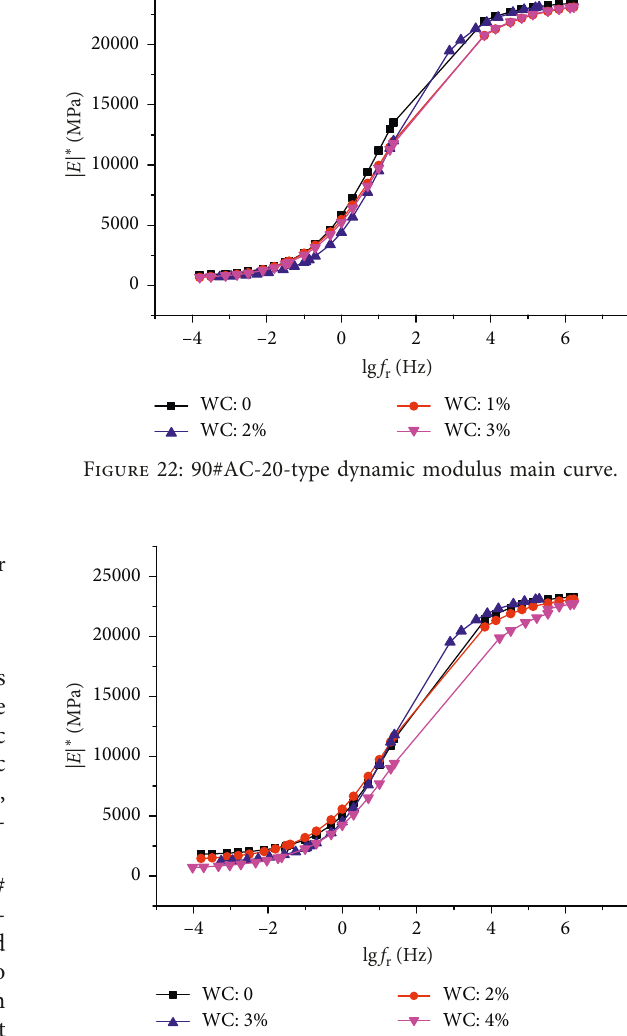
Figure 23: SBS#AC-20-type dynamic modulus main